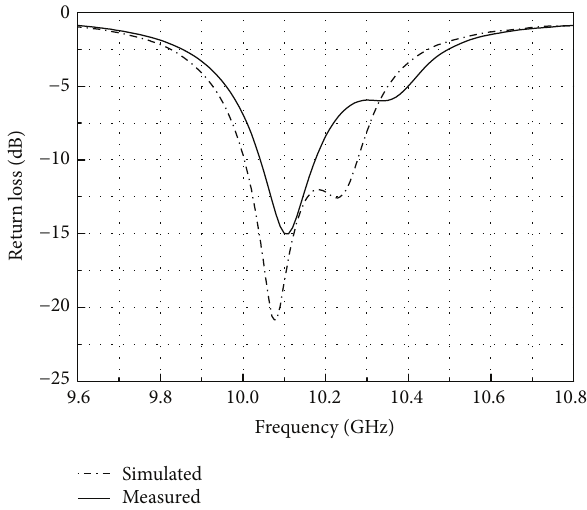
Figure 5: Measured return loss of the fabricated antenna compared with its simulated result.